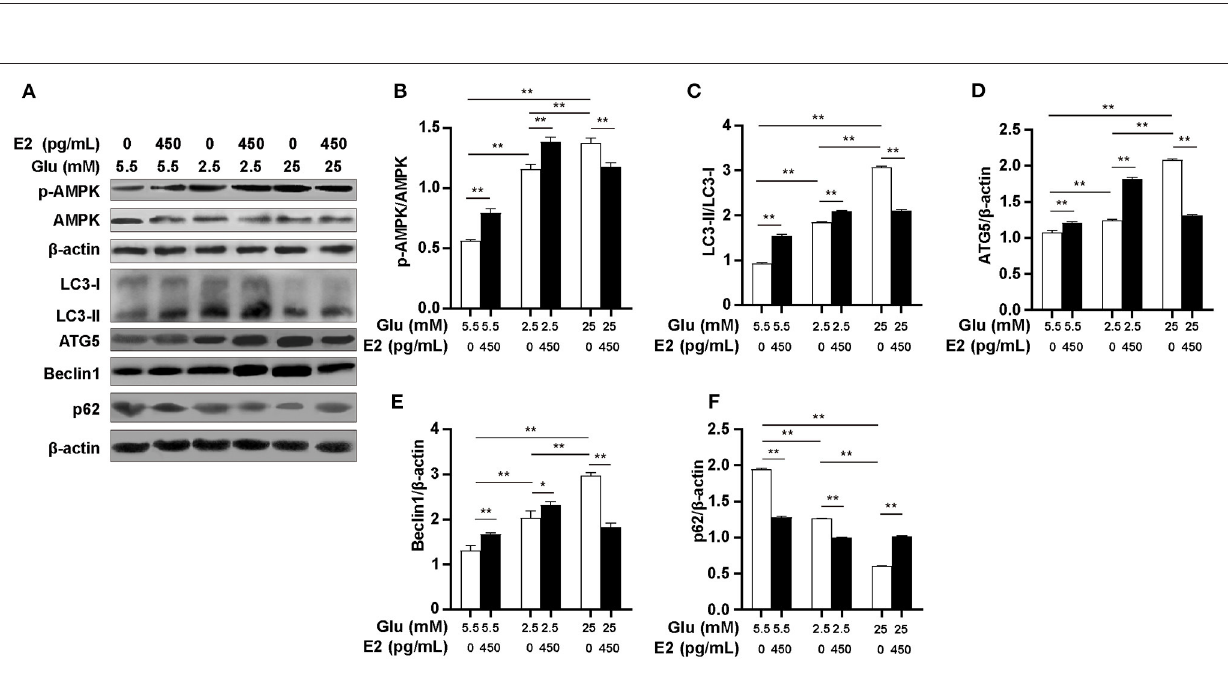
FIGURE 5 | E2 regulates AMPK-dependent autophagy in PMNs. PMNs were treated with NG, NG + EH, LG, LG + EH, HG and HG + EH for 6h. (A–F) Expressions of LC3, ATG5, Beclin1, p62, p-AMPK and AMPK were analyzed by WB with β -actin used as an internal control. The results are shown as the mean ± SD ( n = 3). Differences were analyzed using the t -test.* P < 0.05, ** P <